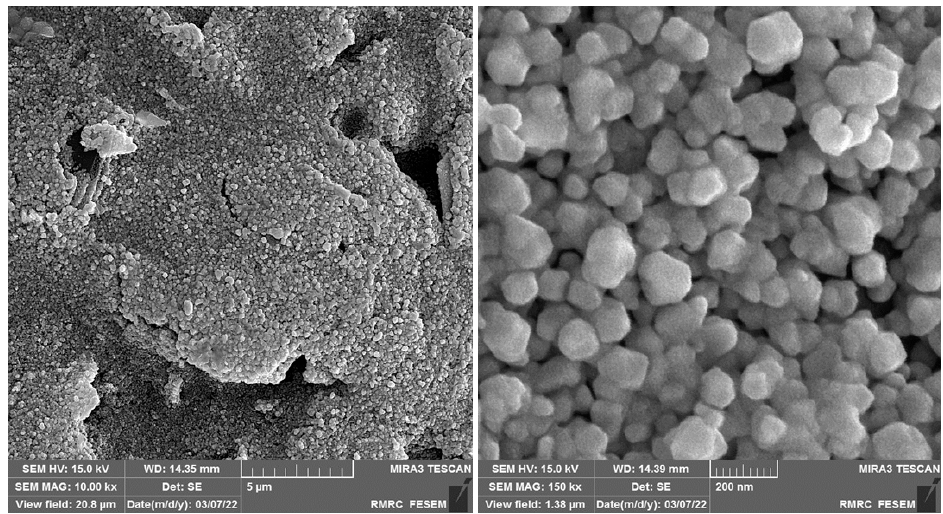
Figure 1. FE-SEM images of Au-NS modified CPE at different magnifications.